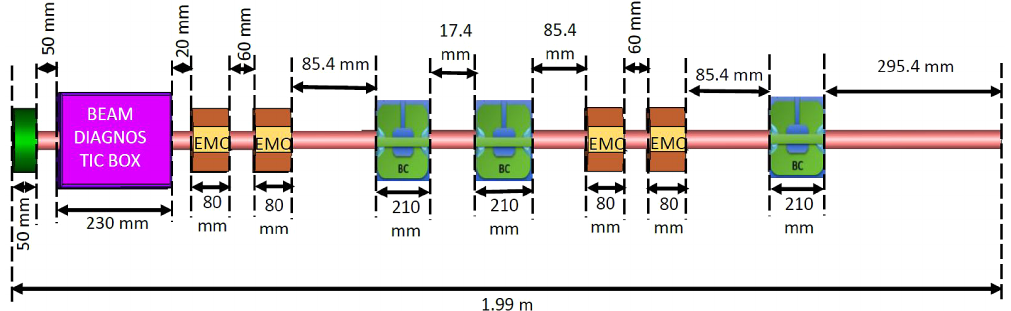
FIG. 11. Layout of the MEBT demonstrating the position and dimensions of the quadrupole doublets and buncher